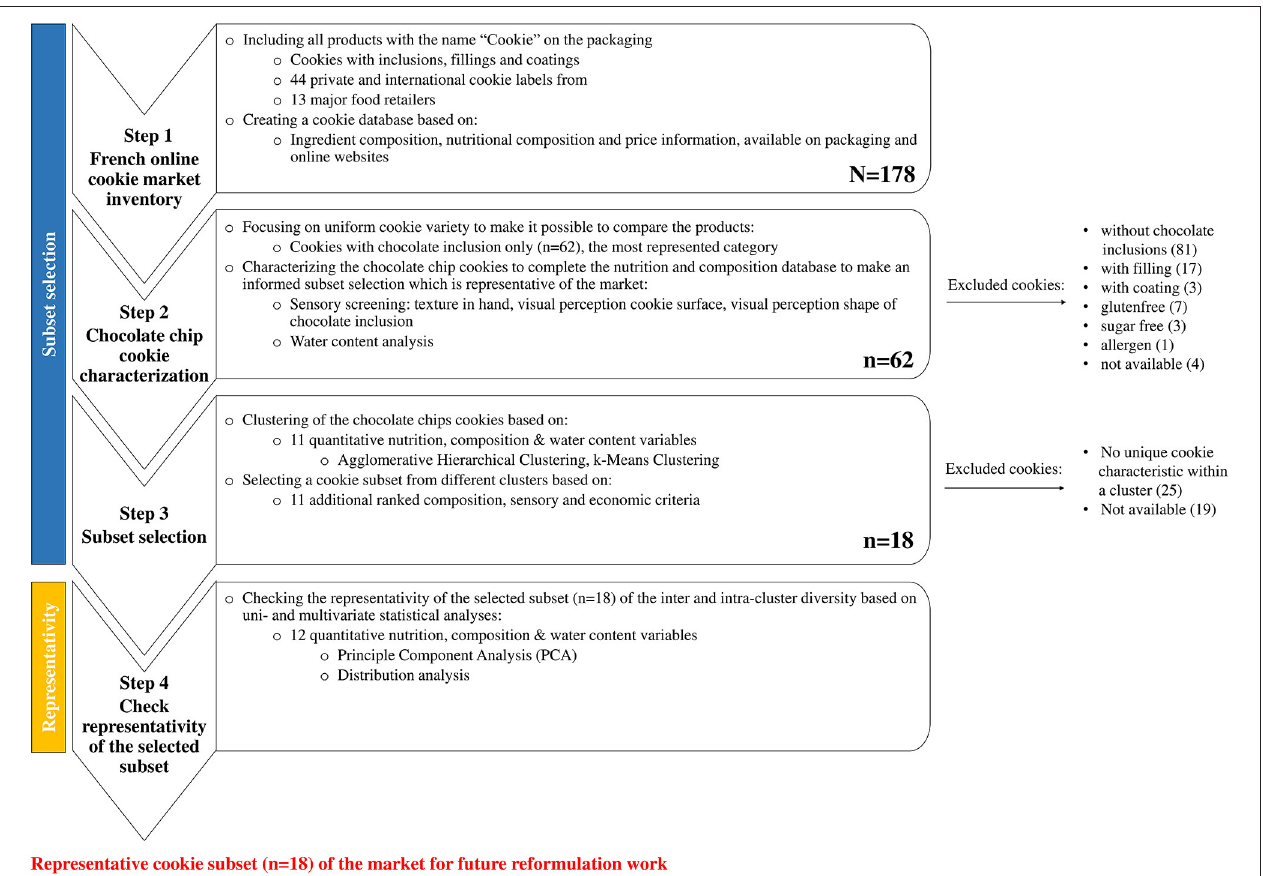
FIGURE 1 | Overview of the four steps from the online cookie market inventory to the selected subset and its check of the